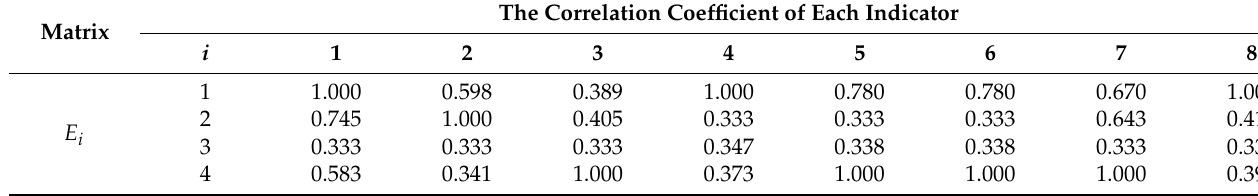
Table 20. Correlation coefficient matrix.